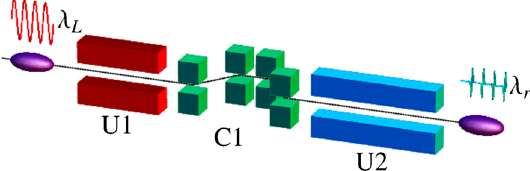
modulates the L . r